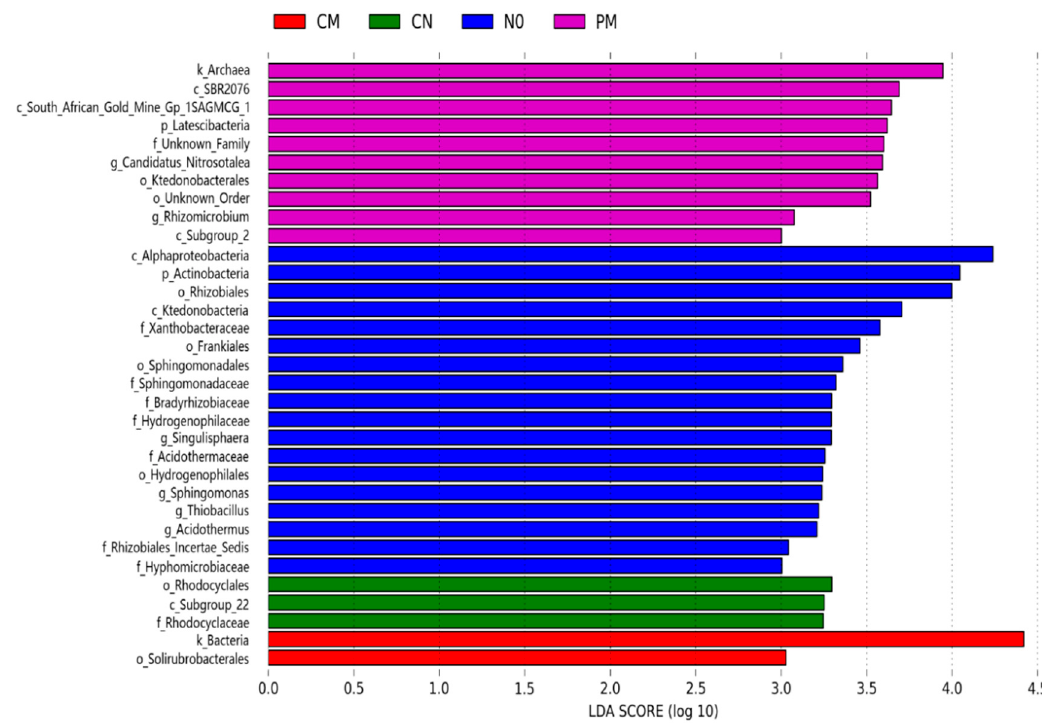
Figure 4. Taxonomic cladogram obtained from the LEfSe of 16S rDNA sequences. NO: no N fertilizer. CN: 100% urea N with no organic fertilizer. PM: 80% urea N plus 20% N with pig manure. CM: 80% urea N plus 20% N with compost.